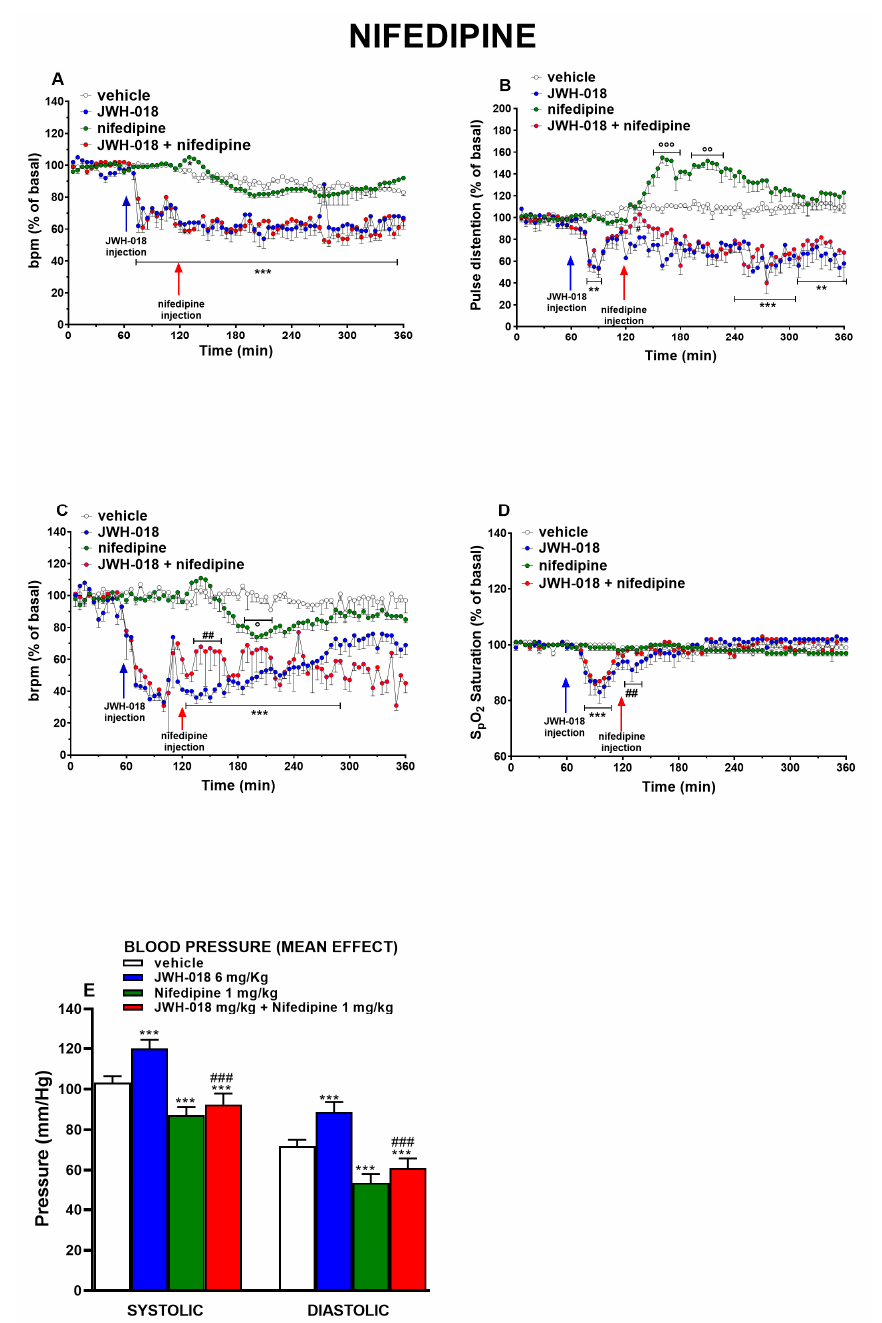
Figure 5. Effect of systemic administration of JWH-018 (6 mg/kg), nifedipine (1 mg/kg), or JWH-018 followed by nifedipine on heart rate ( A ), pulse distention ( B ), breath rate ( C ), and arterial saturation ( D ). Data are expressed as percentage of basal values in the form Mean ± SEM of eight different evaluations for each group. Statistical analysis was performed by two-way ANOVA followed by Bonferroni’s test for multiple comparisons. ** p < 0.01, *** p < 0.001, JWH-018 versus vehicle. ## p < 0.01, JWH-018 versus JWH-018 + nifedipine. ◦ p < 0.05, ◦◦ p < 0.01, ◦◦◦ p < 0.001, JWH-018 nifedipine versus vehicle. Changes in systolic and diastolic blood pressure ( E ). Data are expressed as absolute values (mmHg) of average effect. Statistical analysis was performed by one-way ANOVA followed by Bonferroni’s test for multiple comparisons. *** p < 0.001 versus vehicle. ## p < 0.01 JWH-018, ### p < 0.001 versus JWH-018 +